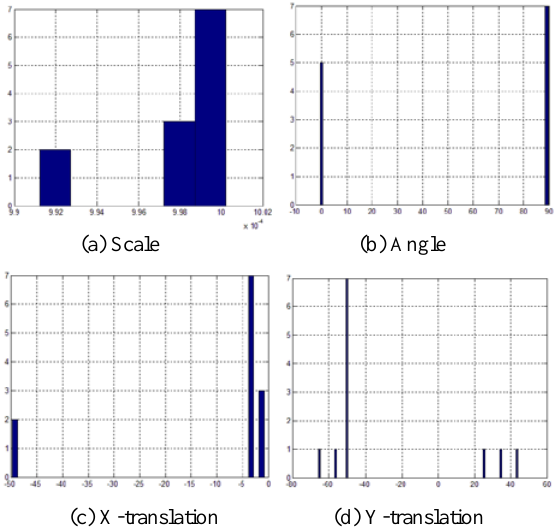
Figure 8. Accumulators for voting for the transformation